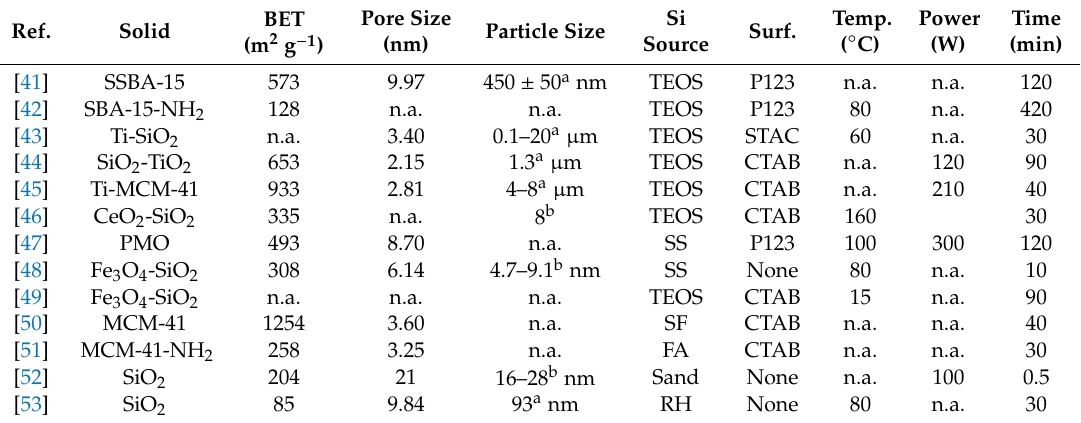
Table1. Synthesisparametersandcharacterizationofthesolidspreparedforwasteremovalapplications.